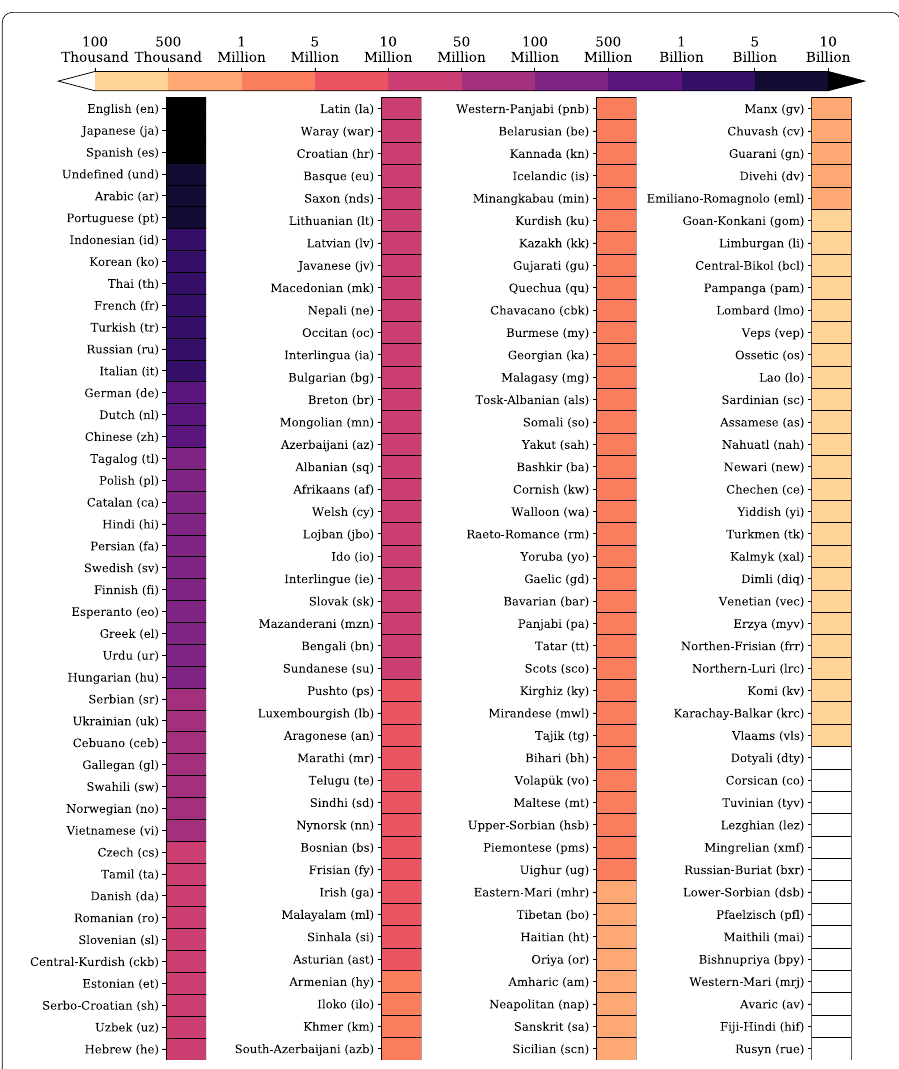
tweet into two separate messages: a comment and a retweet. We exclude retweets while including all added text (comments) found in quote tweets for the OT